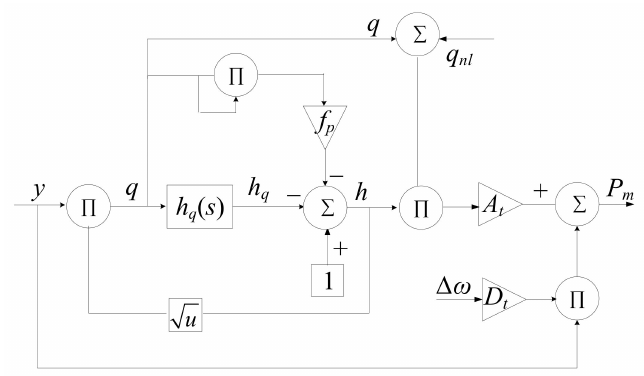
Figure 2. The block diagram of the hydro turbine. A t is the hydro-turbine gain. h and q are the deviation of the water head and flow of the hydro turbine, respectively. fp is the head loss coefficient p m is the relative value of the output mechanical power. q n1 is the no-load flow deviation. ∆ ω is the deviation value of the angular velocity of the unit. D t is the damping factor. hfc is the relative value of the pipe friction head loss. y is the guide vane opening. h q denotes the variation of the water head of the hydro turbine caused by the flow change of the